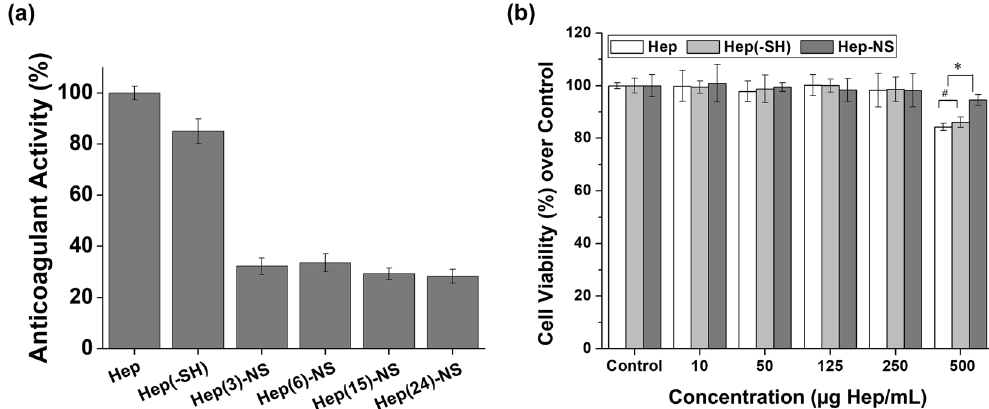
Figure 3. ( a ) Anticoagulant activity of heparin, thiolated heparin, and heparin nanosponge (Hep-NS) measured by its binding affinity to AT-III. (b) Cytotoxicity of heparin, thiolated heparin, and heparin